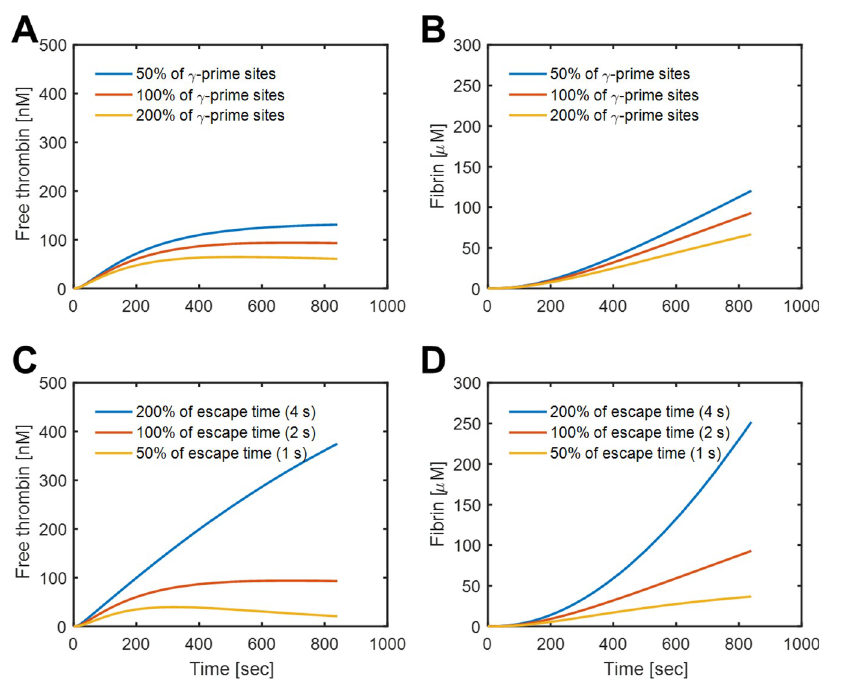
Fig 4. Effect of γ ’ site concentration and escape time on thrombin and fibrin. The thrombin (A) and fibrin concentration (B) at 50%, 100%, and 200% of normal levels of γ ’-fibrinogen. The thrombin (C) and fibrin concentration (D) for different diffusional escape times of free thrombin from the